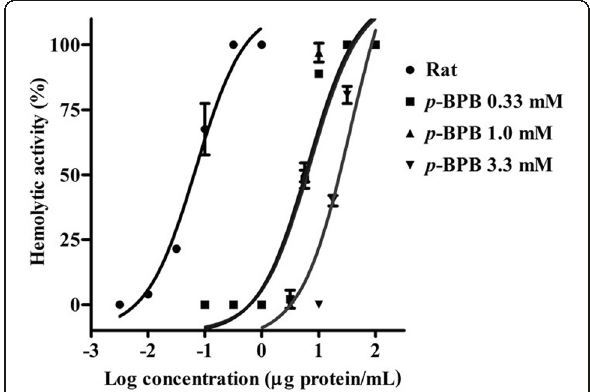
Fig. 3 Concentration-response curves showing the effect of p -BPB, a PLA 2 inhibitor, on the hemolytic activity of the M. alcicornis aqueous extract